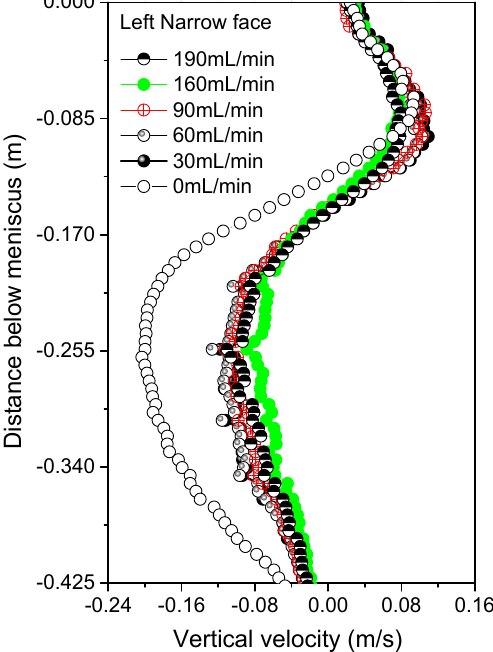
Figure 19. Effect of gas flow rate on the surface horizontal velocity.